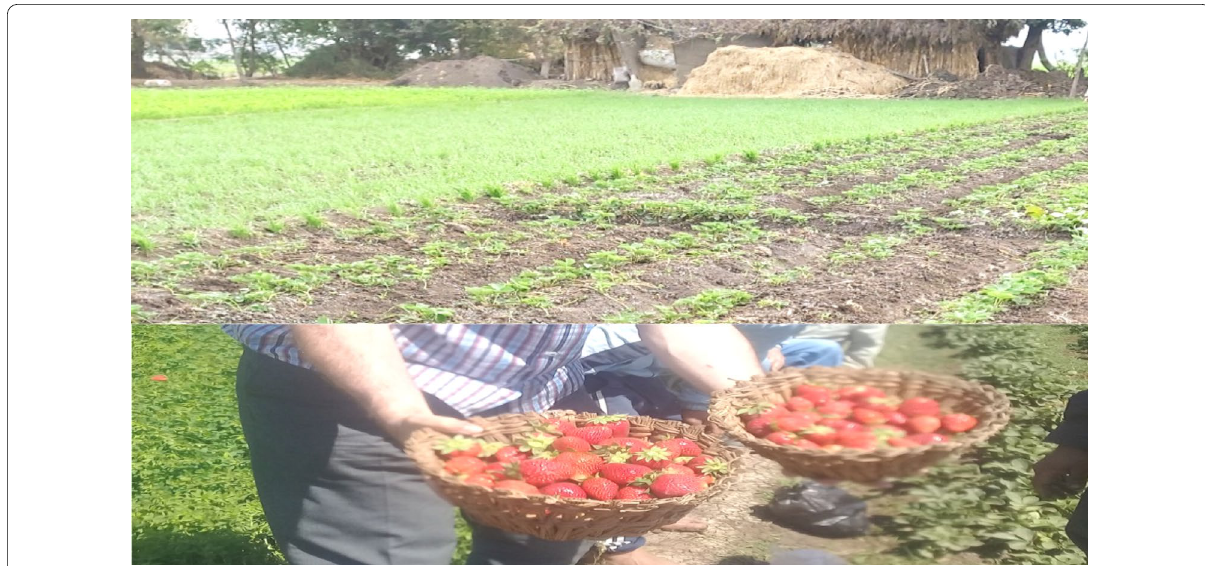
Fig. 2 Upper: strawberry with the treatments (upper left) adjacent to (right) the untreated check. Lower: more strawberry yield fruits from salt‑treated (left) than untreated